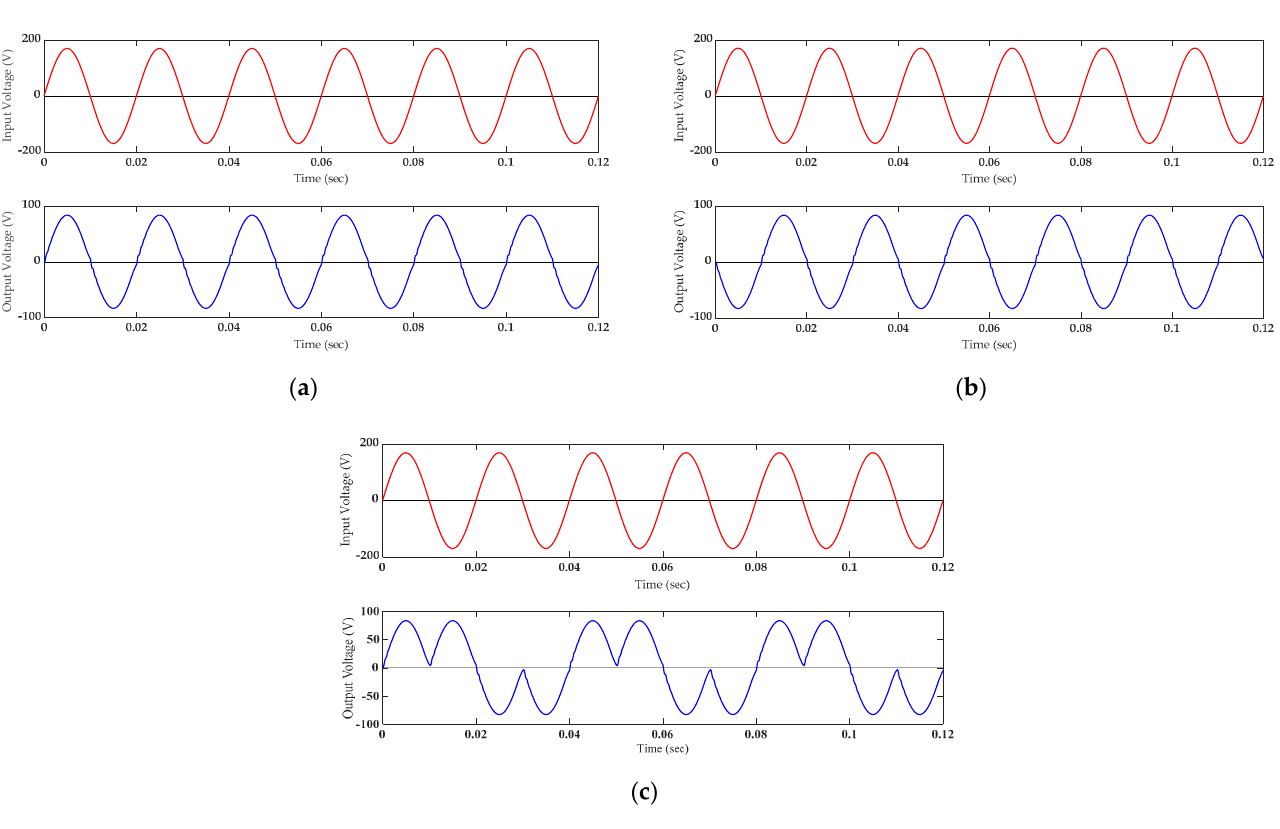
Figure 6. Simulation waveforms of output voltage (blue) with respect to input voltage (red) for the voltage gain of 0.5: ( a ) voltage in-phase form; ( b ) voltage out-of-phase form; ( c ) frequency regulation form.